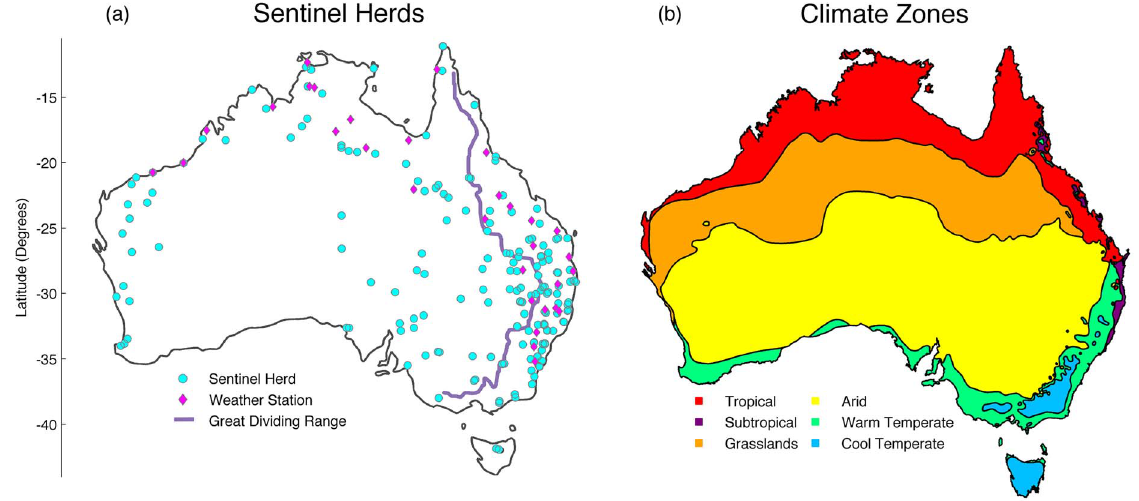
Figure 1. (a) Map of Australia indicating the location of sentinel herds (circles) and weather stations used for climactic data (diamonds), as well as the Great Dividing Range (purple line), and (b) Australia’s climate zones as defined by the Australian Bureau of Meteorology.